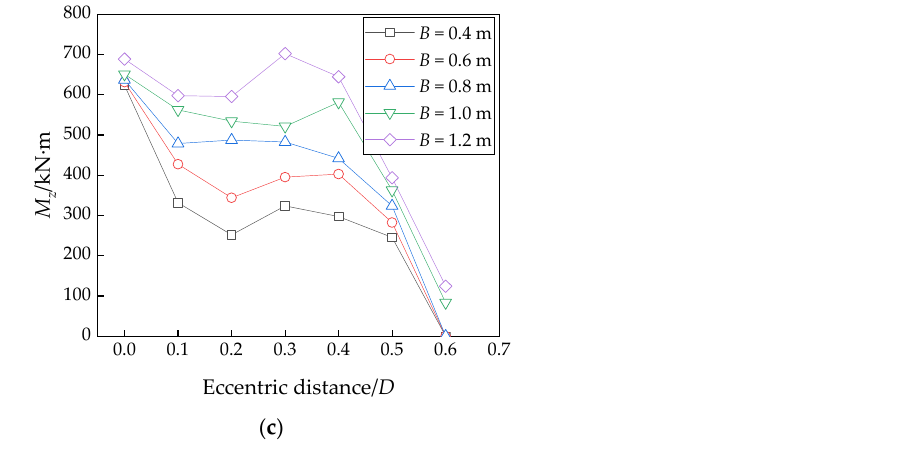
x ; ( b ) M y and ( c ) M z